Question: In one sentence, what is this figure communicating?
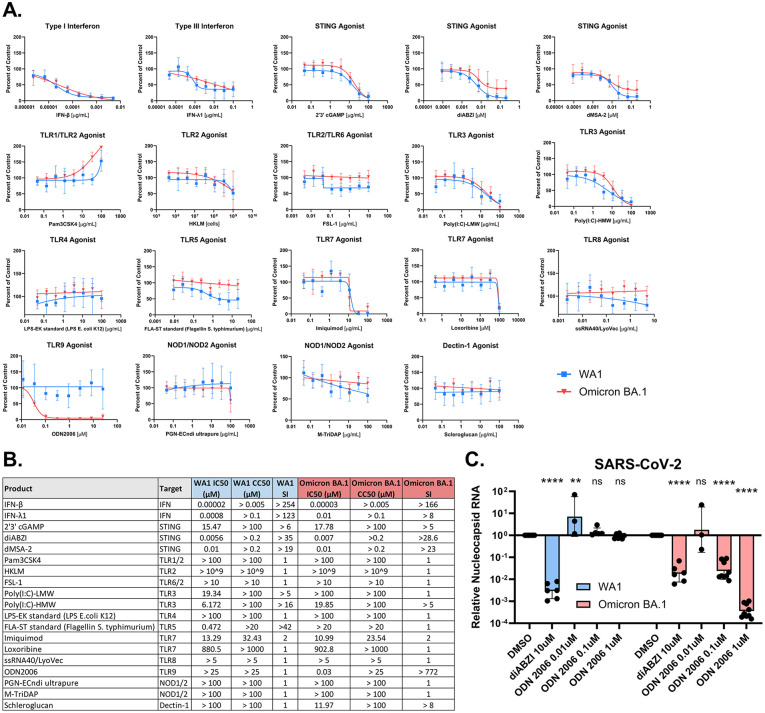
Answer: ODN2006 is selectively antiviral against SARS-CoV-2 Omicron BA.1. (A) Calu-3 cells were pre-treated with innate immune agonists in 8-pt dose-response for two hours and then infected with SARS-CoV-2 (MOI 0.5) WA1 ancestral strain (blue) or Omicron BA.1 (red) for 48 hours (h) and processed for automated microscopy and image analysis quantifying total cell numbers and percent infection (dsRNA + /nuclei+) to determine Percent-of-Control (POC) % positive. Each data point represents the mean ±SD of n = 6 biological replicates. (B) IC50, CC50, and SI are listed for each compound. (C) Calu-3 cells were pre-treated with vehicle (DMSO), diABZI positive control, or ODN2006 for 2h and infected with WA1 or BA.1 (MOI 0.2) for 48h prior to processing for RT-qPCR analysis of viral RNA (Nucleocapsid). Means ±SD with individual biological replicates shown. Significance was calculated using One Way ANOVA with Dunnett Correction on DMSO control (**p < 0.01, ****p < 0.0001; ns, no significance).